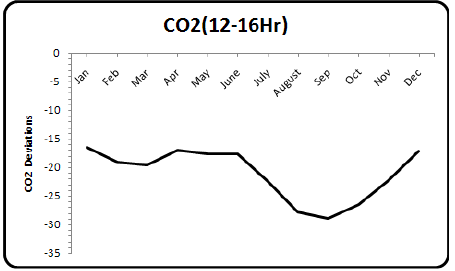
Figure 3: Observed atmospheric CO 2 deviations during 12-16 hours LT at Dehradun during